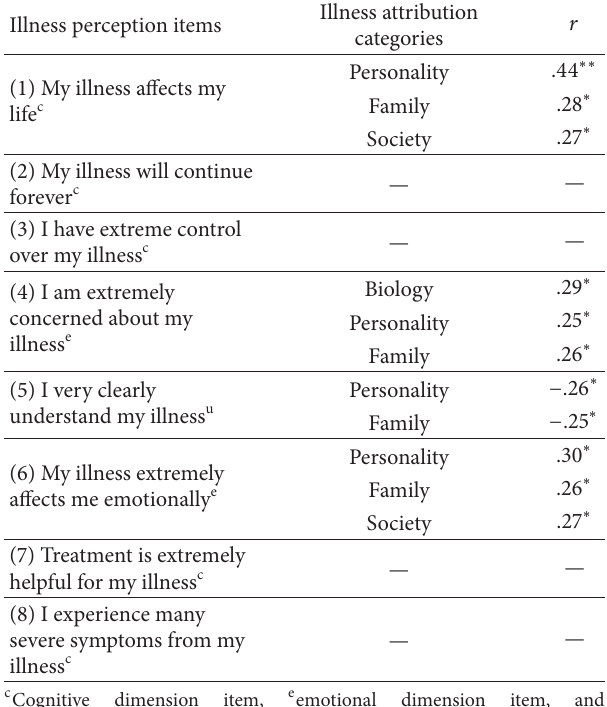
Table 3: Significant correlations between illness perception items and illness attribution categories ( 𝑁 =